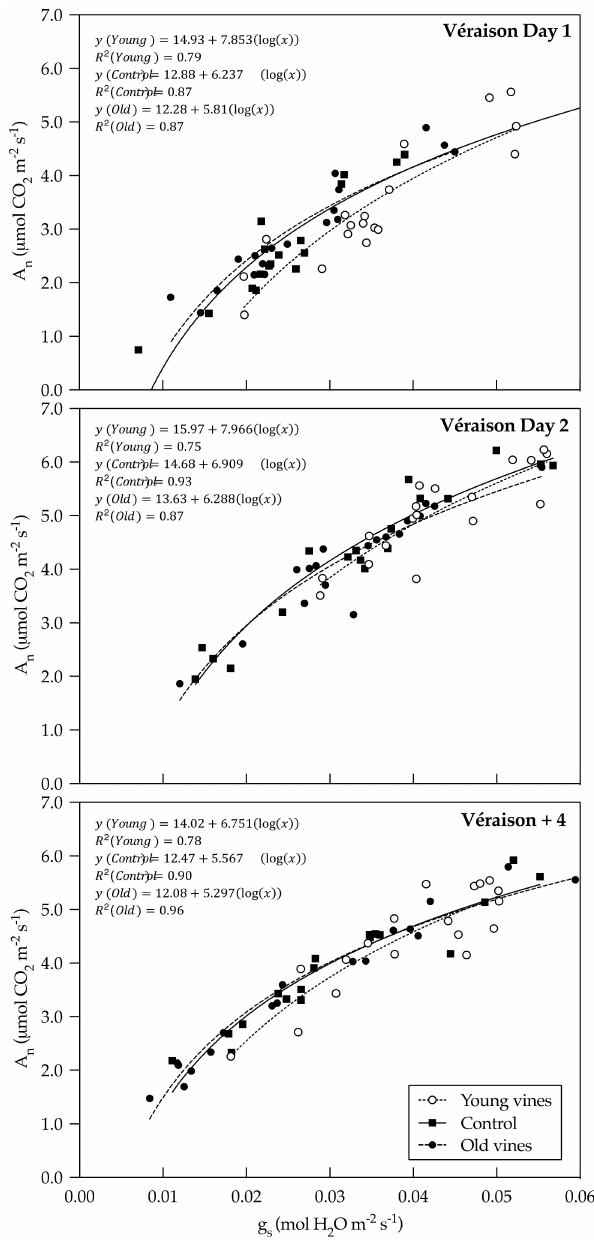
Figure 4. Relationships between mid-day photosynthetic rate (A n ) and stomatal conductance (g s ) at different growth points in the 2020 growing season. V é raison + 4 corresponds to four weeks post-v é raison. Curves of logarithmic regressions of Young and Old vines are significantly different on V é raison day 1 ( p =